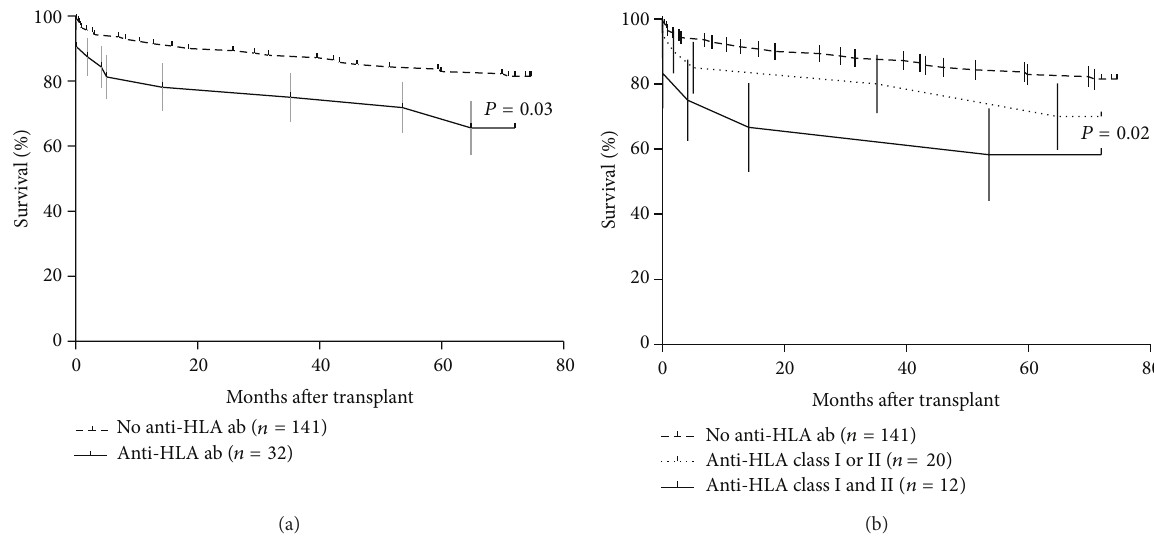
Figure 2: Kaplan-Meier estimate survival in patients with HLA ab. (a) Overall survival in patients with (solid line) and without (dotted line) pretransplant HLA ab. Vertical lines indicate standard errors of the survival estimate. (b) Overall survival according with HLA antibodies against either class I or II alone (dotted line), both class I and II (solid line), or no HLA antibodies. Vertical lines indicate standard errors of the survival estimate.